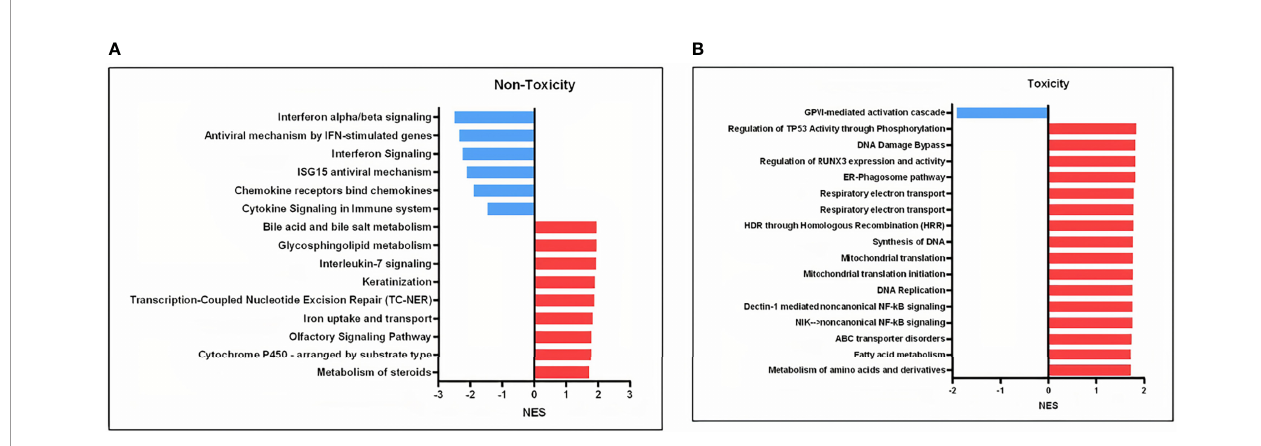
FIGURE 4 | Involved pathways in cell response to 8 Gy comparing irradiated to non-irradiated samples in the toxicity and non-toxicity patients. (A) Gene sets exclusively downregulated (blue) and upregulated (red) in the non-toxicity group after 8 Gy. (B) Gene sets exclusively downregulated (blue) and upregulated (red) in the toxicity group after 8 Gy. NES, normalized enrichment